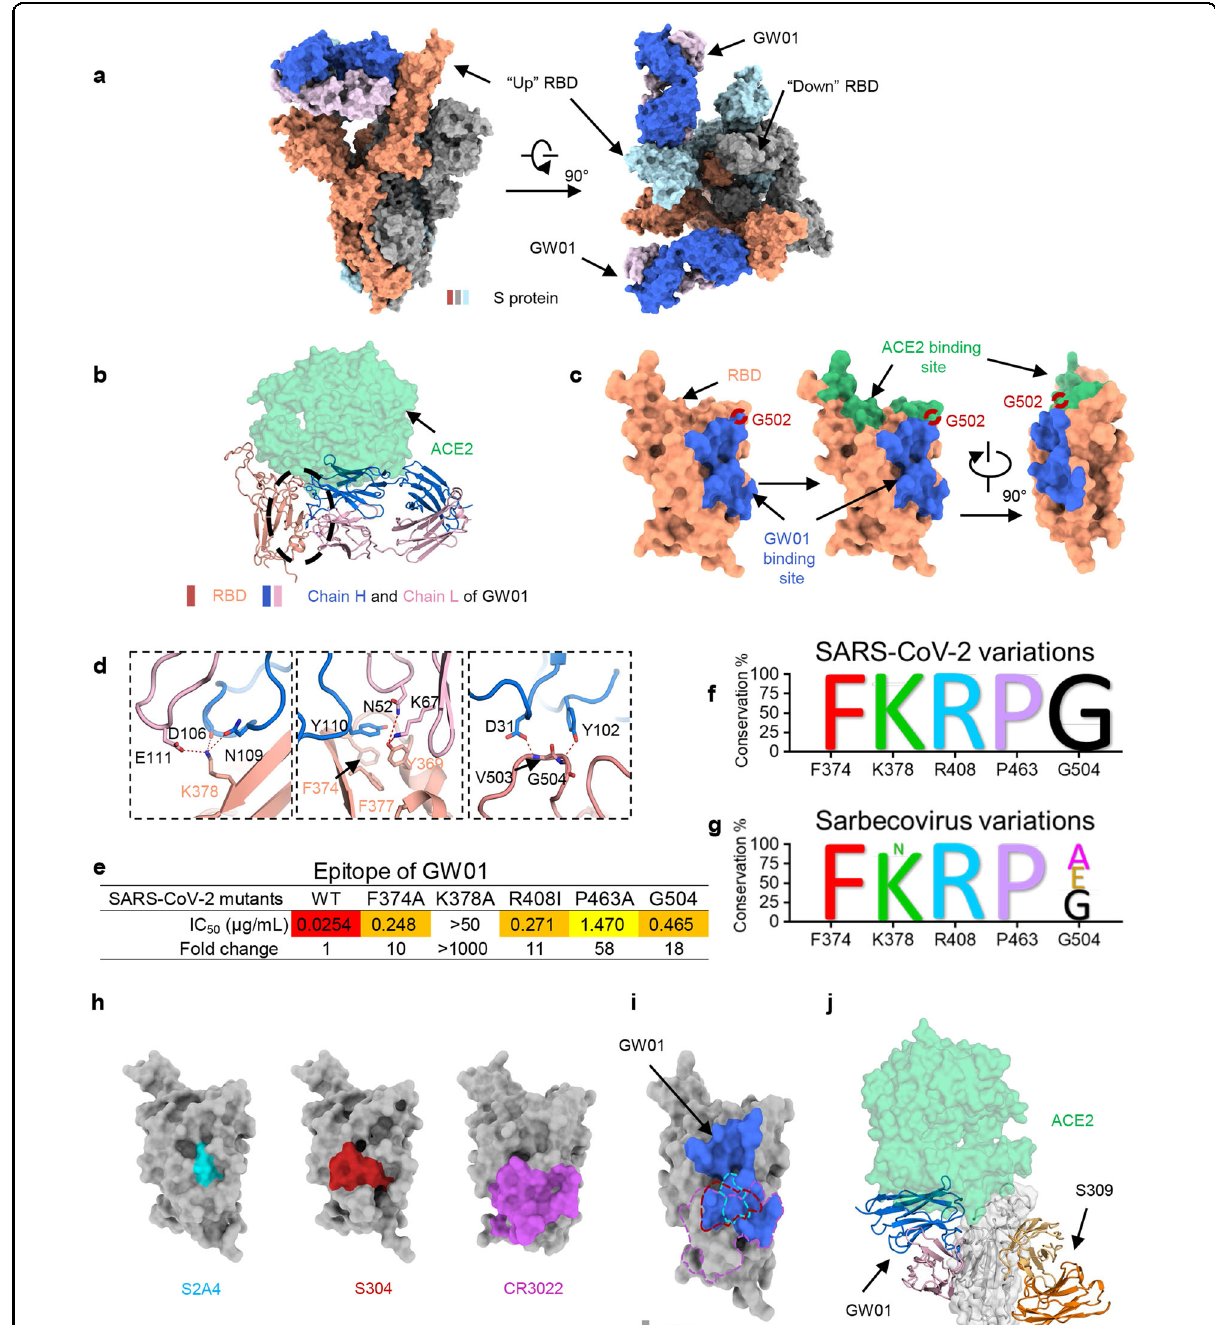
Fig. 3 GW01 targets a conserved RBD epitope shared by the spike proteins of different sarbecoviruses. a The domain-colored cryo-EM structure of GW01 bound with S-ECD is shown in two perpendicular views. The heavy (blue) and light (pink) chains of GW01 bind to two “ up ” RBDs. Two up RBD monomers are colored orange and light blue, while the down RBD is colored gray. b Structural comparison of epitopes between ACE2 (green) and GW01 bound to RBD. The black circle includes extensive hydrophilic interactions on the interface between GW01 and RBD. c The binding epitope of GW01 bound to the RBD of S-ECD is colored blue, shown on the left, and is observed to overlap with the green-colored epitope of ACE2 bound to RBD on G502 (red ring). d Detailed analysis of the interface between GW01 and RBD. Polar interactions are indicated by red dashed lines. e Epitope of GW01. Residues that decreased neutralization sensitivities (fold change >10) of GW01. Conservation of residues F374, K378, R408, P463, and G504 in SARS-CoV-2 variant sequences ( f ) and different sarbecoviruses ( g ). h The RBD epitopes of S2A4 (PDB ID: 7JVC), S304 (PDB ID: 7JW0), and CR3022 (PDB ID: 6W41), which are colored cyan, red, and violet, respectively. i Comparison of RBD epitopes between GW01 and S2A4, S304, and CR3022. The RBD epitopes of S2A4, S304, and CR3022 are shown as meshes and are colored cyan, red, and violet, respectively. j Structural classi fi cation of GW01 and S309 (PDB ID: 6WPT) with no overlaps between them. In GW01, the heavy chain and light chain are shown in blue and pink, respectively, and in S309, they are shown in orange and wheat,